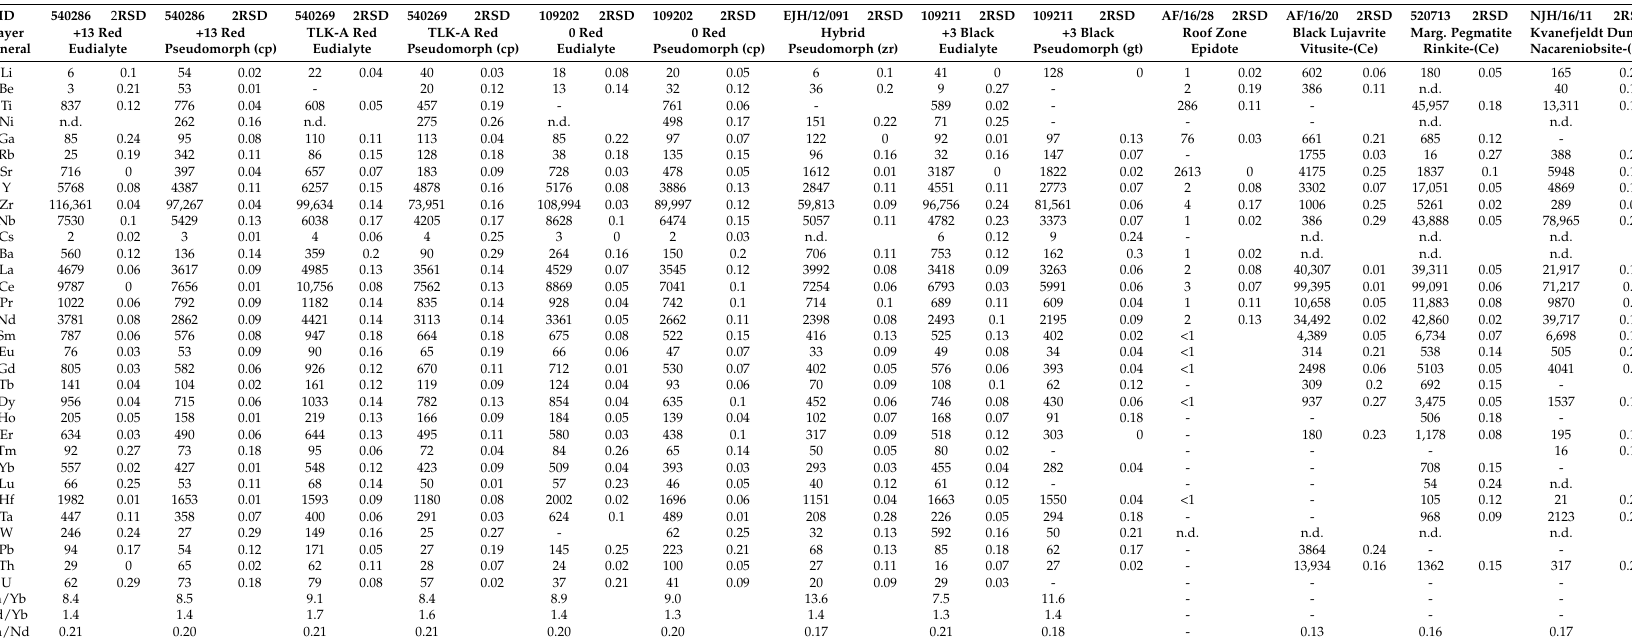
Table 3. Selected major and trace element concentrations as determined by ICPMS (in ppm). Data are averages of two analyses and errors are two relative standard deviations (RSD) of the two analysis series. Concentrations with 2RSD > 30% are excluded (-), n.d. = not detected. cp = catepleiite-type, gt = gittinsite-type and zr = zircon-type